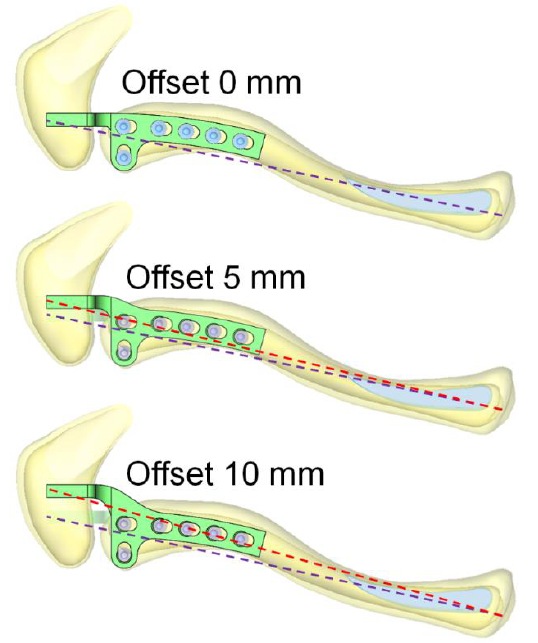
Figure 9. The existence of a posterior hook offset increases the lever arm length, resulting in a smaller reaction force on the acromion.